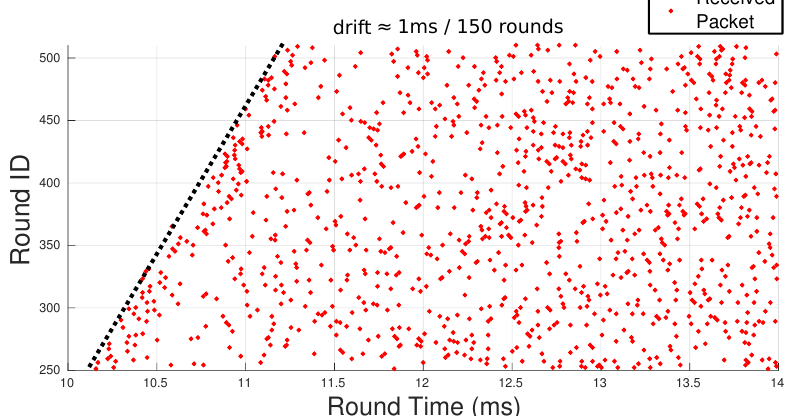
Figure 13. Nodes synchronized using NTP at the beginning of the mission, only. Per line, we can see the reception instants of packets sent by the source in the corresponding receiver slot at the first relay. The transmitter and receiver slots show a clear drift of, approximately, 1 ms every 150 rounds (drift